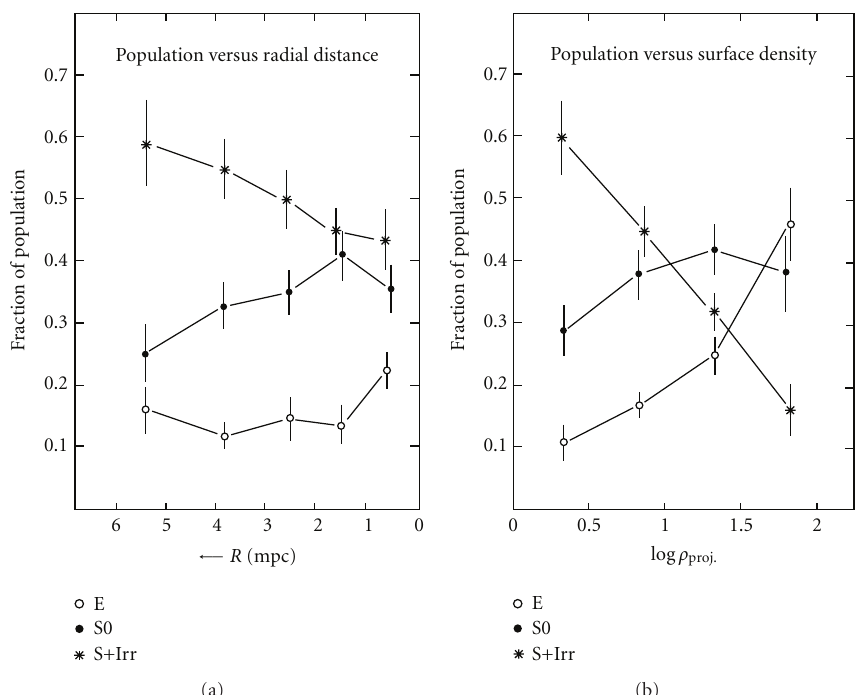
Figure 20: Galaxy population gradients in galaxy clusters as a function of radial distance from the cluster center (a) and local galaxy density (b) Credit: Dressler [262]. Reproduced by permission from the AAS. relative velocity between the galaxy and the ICM. This e ff